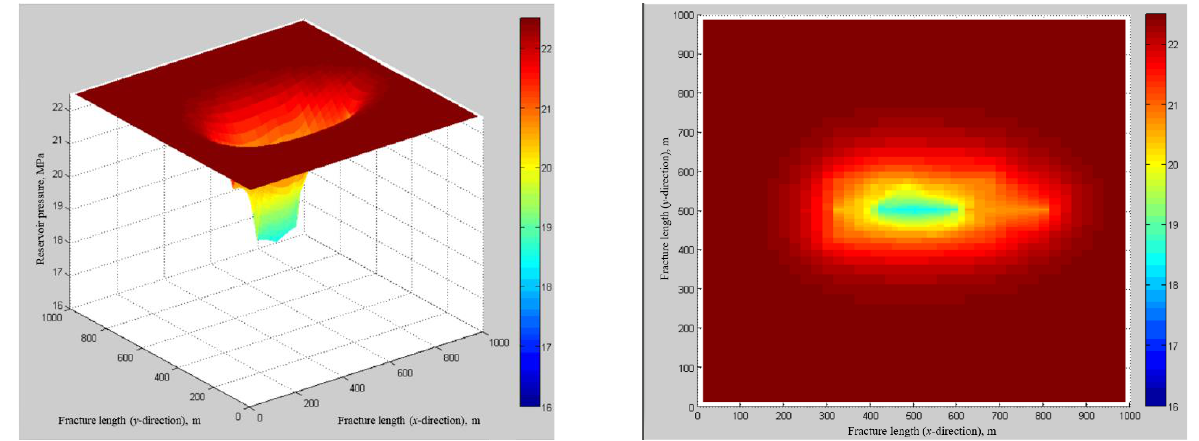
Figure 12. Reservoir pressure distribution at the time of 100 days.